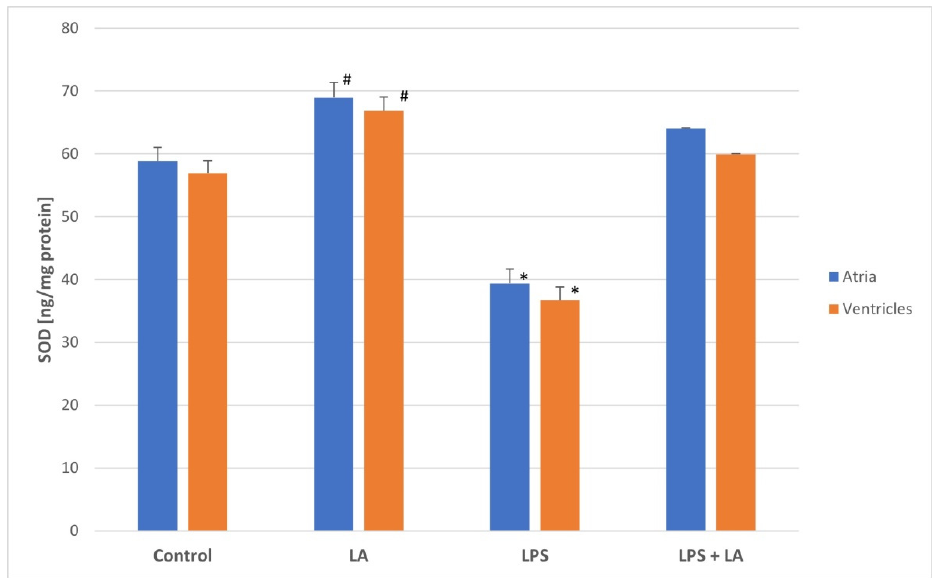
Figure 3. Effect of LA, LPS, and LPS + LA on SOD activities in ventricular and atrial homogenates. Results are shown as mean ± S.E.M. n = 8. * p < 0.05 vs. control, LA, LPS + LA; # p < 0.01 vs. control. LA—alpha lipoic acid, LPS—lipopolysaccharide.